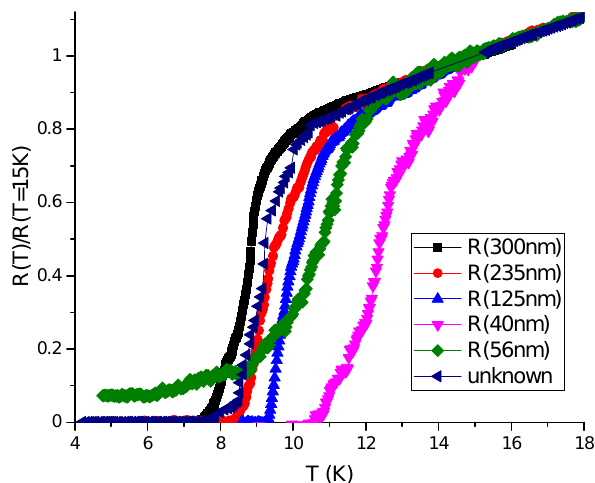
Figure 3. Measured temperature dependence of normalized resistance R zz ( T ) / R zz ( T = 15 K ) in several samples of the same in-plane size 2 × 2 µm 2 but of different thickness.